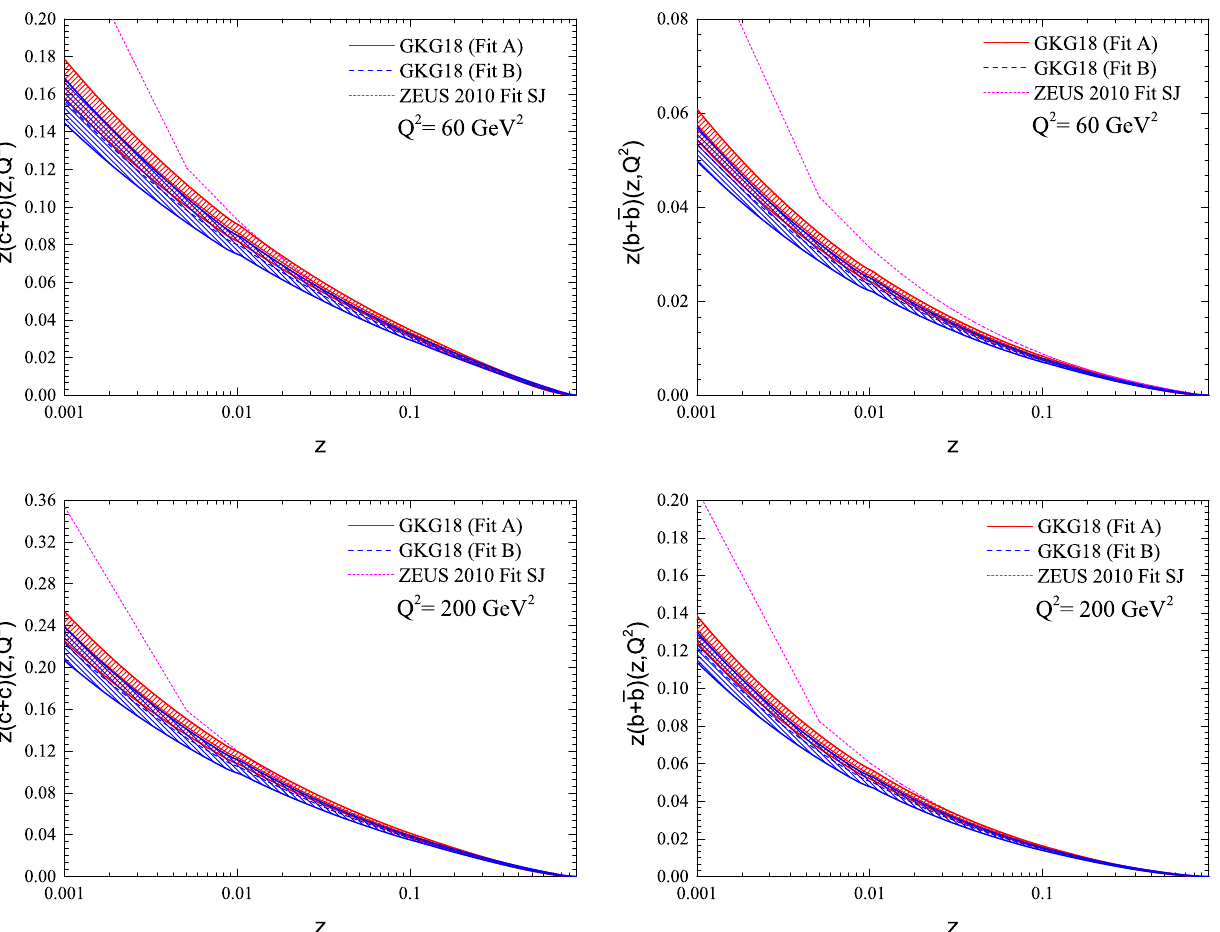
Fig. 6 (Color online) The charm z ( c + ¯ c )( z , Q 2 ) (left) and bottom z ( b + ¯ b )( z , Q 2 ) (right) quark diffractive PDFs obtained from our NLO QCD fits at selected Q 2 value of Q 2 = 60 and 200 GeV 2 . The error bands correspond to the fit